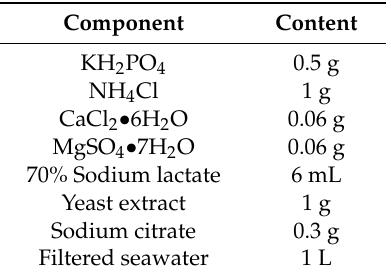
Table 1. The composition of Postgate’s C